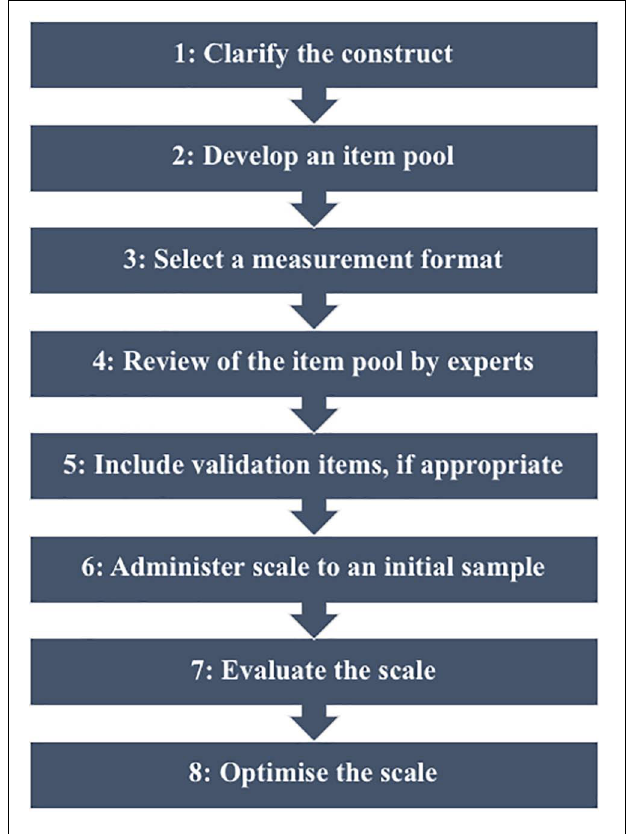
FIGURE 1 | Steps in scale development (DeVellis,